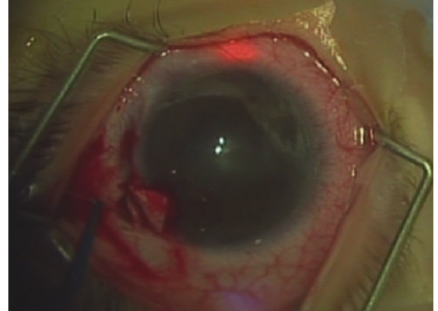
Figure6:360degreetrabeculotomyinanewbornchild.Illuminated catheter progressing around Schlemm’s canal at 12 o’clock evidenced by red light.